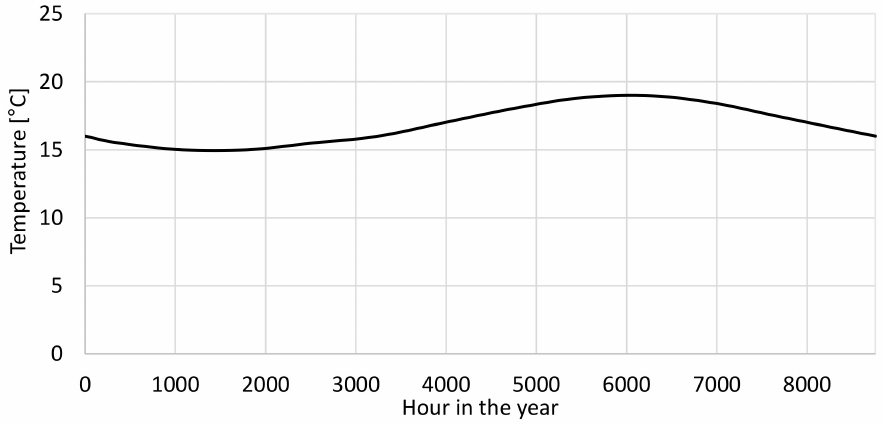
Figure 6. Temperature of groundwater at the supply well.